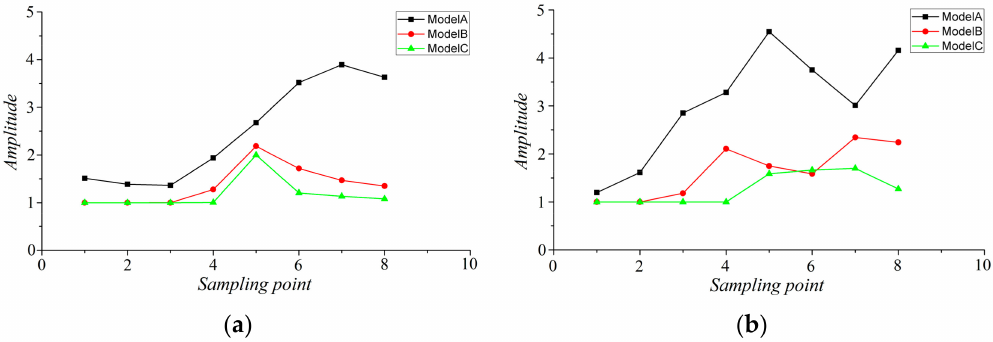
Figure 14. Amplitude change at sampling point. ( a ) Upper wall. ( b ) Lower